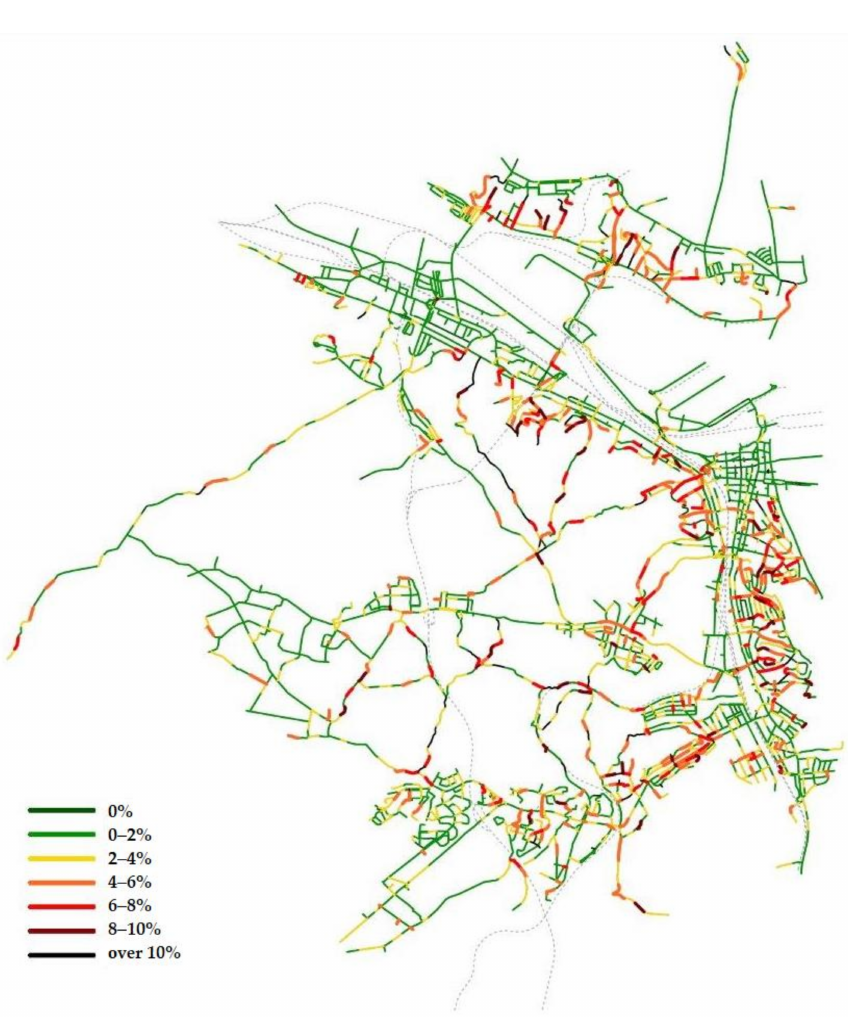
Figure 2. Slopes of bicycle routes in